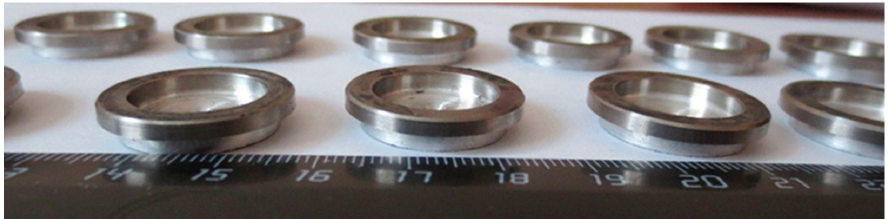
Figure 7. Tear strength specimens.